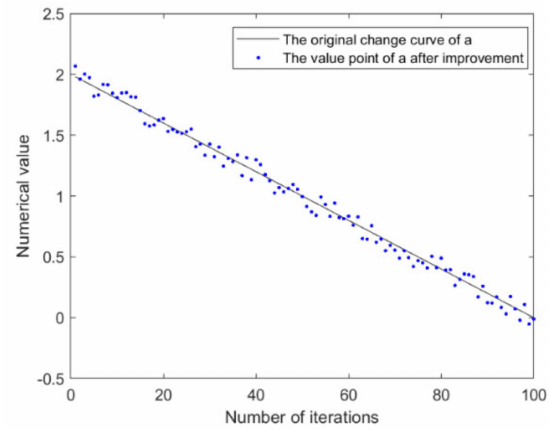
Figure 12. Variation of a with increasing number of